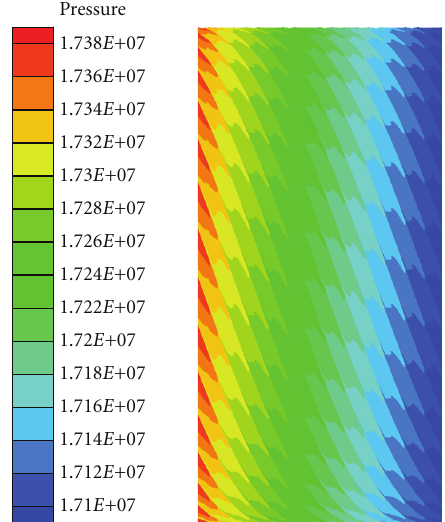
Figure 9: Pressure contour of 20deg